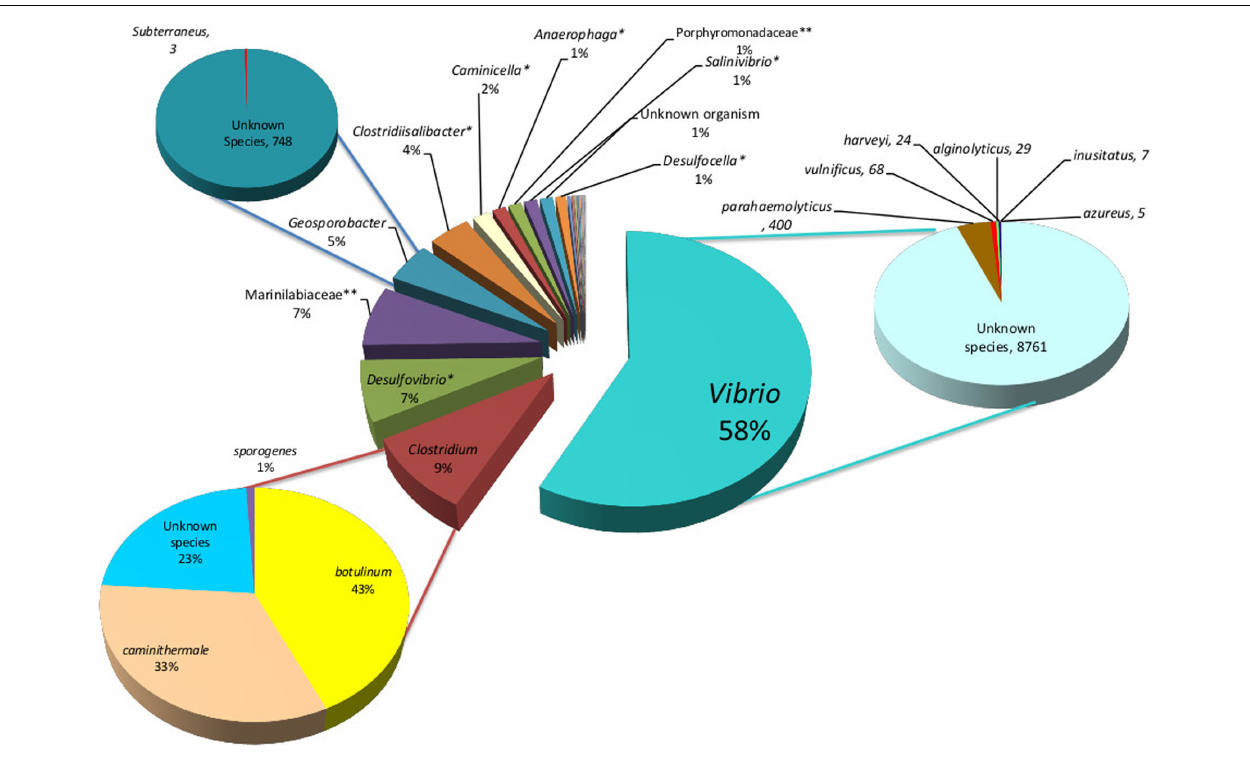
FIGURE 3 | Solar Lake West genera are presented in the middle pie chart, predominated by Vibrio (58%), Clostridium (9%), unknown species of Desulfovibrio (7%) and Geosporobacter (5%). The Vibrio ,